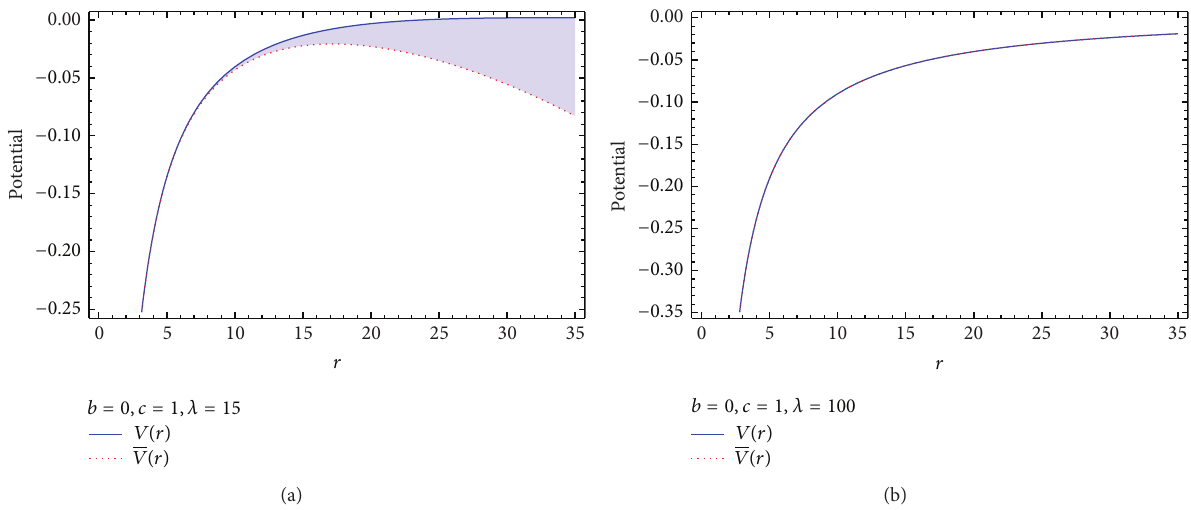
Figure 2: (a) Comparison of 𝑉(𝑟) and 𝑉(𝑟) potentials in case of 𝑏 = 0 , 𝑐 = 1 , and 𝜆 = 15 (in arbitrary units). (b) Comparison of 𝑉(𝑟) and 𝑉(𝑟) potentials in case of 𝑏 = 0 , 𝑐 = 1 , and 𝜆 = 100 (in arbitrary units).